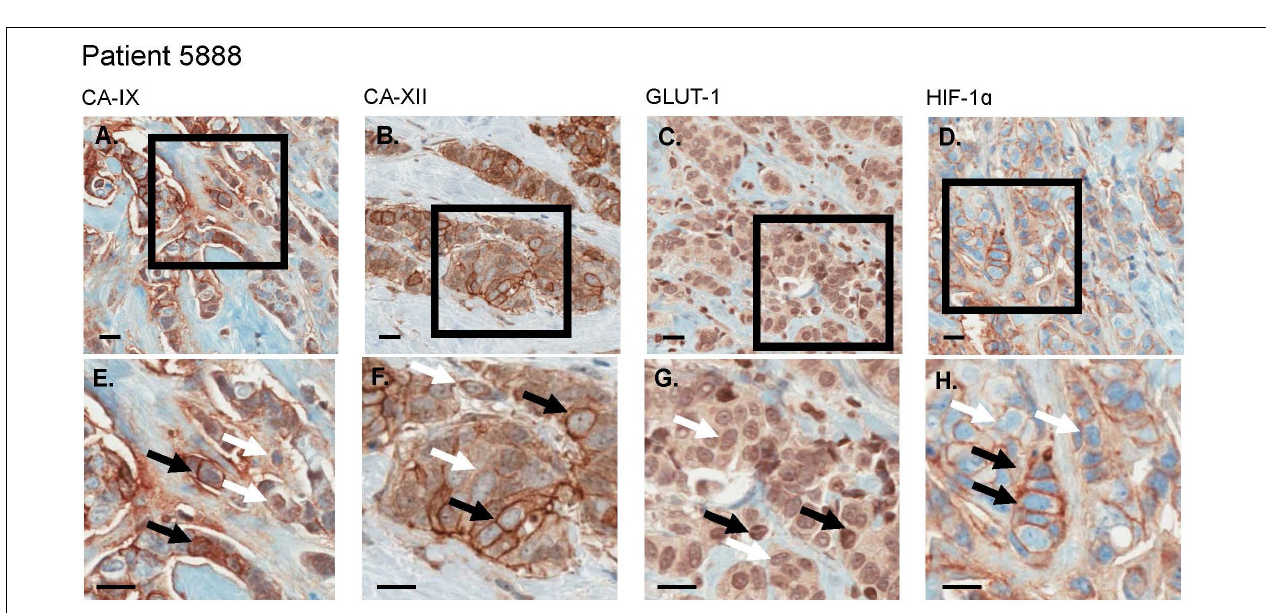
FIGURE 6 | For a single invasive breast cancer patient (A) , image analysis techniques we used to segment and classify cancer (orange), normal breast tissue (dark blue) and normal adipose tissue (light blue) regions of interest (B) . Black bounding box represents the region of interest evaluated in more detail in Figure 7 . All scale bars = 5 mm.